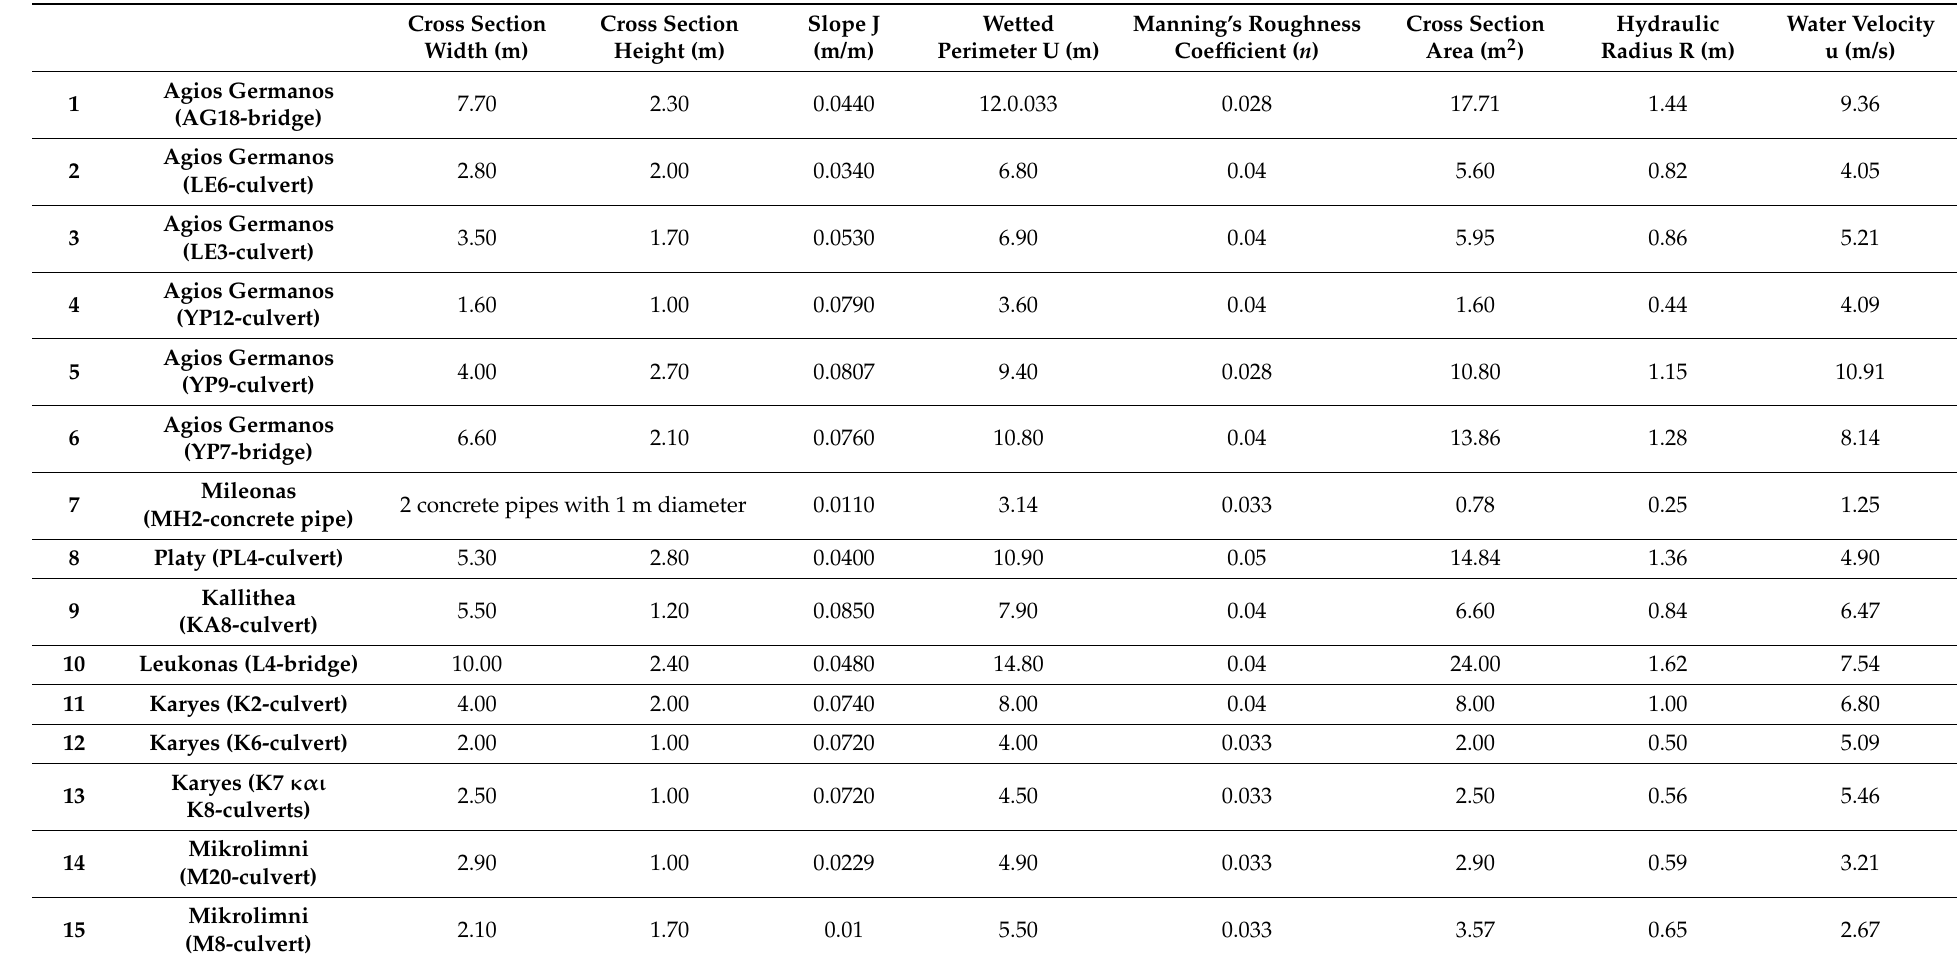
Table 6. Hydraulic characteristics and the water velocity of the examined cross